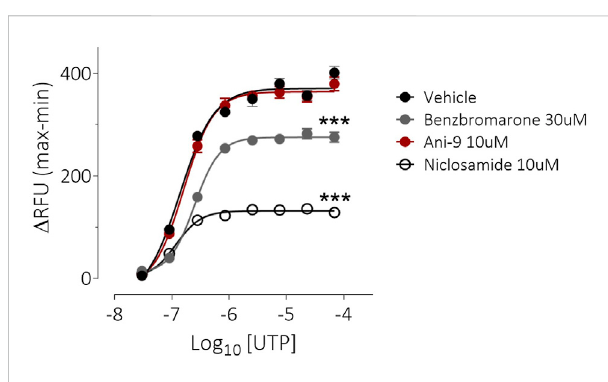
FIGURE 3 Benzbromarone and niclosamide affect UTP-stimulated calcium mobilisation in FRT-hTMEM16Aabc cells. Mean data ±SEM illustrating the effects of a 10 min incubation of FRT-hTMEM16Aabc cells with test compounds on a subsequent UTP-stimulated increase in [Ca 2+ ] i . Cells had been loaded with Calcium6 dye and were stimulated with UTP (0.03 – 69 µM) and the changes in fl uorescence recorded. Peak changes in fl uorescence minusthebaselinelevelsareplotted for each compound. *** denotes p < 0.001 ( n = 6 experiments per